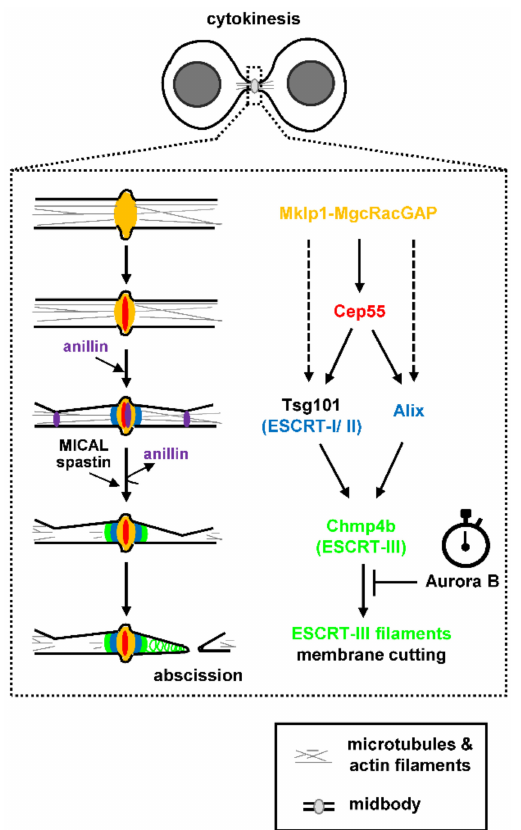
Figure 1. Molecular mechanisms of abscission. Molecular pathways that lead to membrane cutting and clearance of microtubules/actin filaments from the abscission site. See text for details. Potential mechanisms of Tsg101 and Alix recruitment to the midbody that are independent of Cep55 are indicated by dashed arrows. The clock symbol indicates the role of Aurora B as an abscission